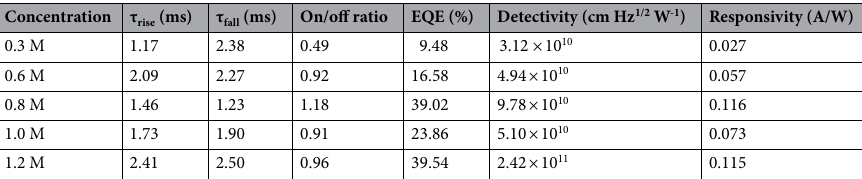
Table S5. The instability is likely from the known problem of using Ag/Au electrode along with Spiro-OMeTAD. Device performances of different Cs contents with unoptimized device conditions are shown in Table S6. As stated above, the films with lower AVT and higher thicknesses are suitable for photodetector applications. The external quantum efficiency (EQE), responsivity (R), and specific detectivity (D*) within 300–900 nm, and characteristics of UV light detections are studied. EQE measures the ratio of electrons generated by a known number of photons 31,68 . Therefore, EQE reflects the relationship between light intensity and generated current. The detail explanations of EQE, R, and D* are carefully stated in our previous report 71 . In Fig. 8a, the highest EQE values were 40.47%, 37.05%, and 6.77% in 1.2 M, 0.8 M, and 0.3 M, respectively, having the same trend as the responsivity curves in Fig. 8b. At 365 nm, the EQE values were 39.54%, 39.02%, and 9.48% for 1.2 M, 0.8 M, and 0.3 M, respectively. Our EQE data strongly indicates that in the range of 300 nm to 430 nm, the films can detect higher amount of the photons compared to other detection ranges. As expected, the clear perovskite materials do not absorb any light after 450 nm. EQE data supports the bandgaps from UV–Vis data, the good solar cell performances under UV exposure, and aptness of 1.2 M, 1.5% Cs perovskite films for UV detector application. For photodetectors, the specific detectivity is determined by main noise and light source in dark 72 . Fig- ure 8c shows that the detectivity becomes higher when the AVT drops. The highest D* values were 2.58 × 10 12 , 1.12 × 10 12 , and 2.55 × 10 10 (cm Hz 1/2 W -1 ) for 1.2 M, 0.8 M, and 0.3 M, respectively. At 365 nm, the D* values were 2.42 × 10 11 , 9.48 × 10 10 , 3.12 × 10 10 (cm Hz 1/2 W -1 ) for 1.2 M, 0.8 M, and 0.3 M, respectively. The normal- ized photo-responses under 365 nm UV light of clear perovskite photodetectors under 100 Hz optical chopper are showed in Fig. 8d. As shown in Fig. 8d, 1.17 ms, 1.46 ms, and 2.41 ms were achieved from 0.3 M, 0.8 M, and 1.2 M for the rise time, while the fall time durations were 2.38 ms, 1.23 ms, and 2.50 ms, respectively. All of our samples demonstrate excellent photodetector performances in terms of τ rise and τ fall among other reported